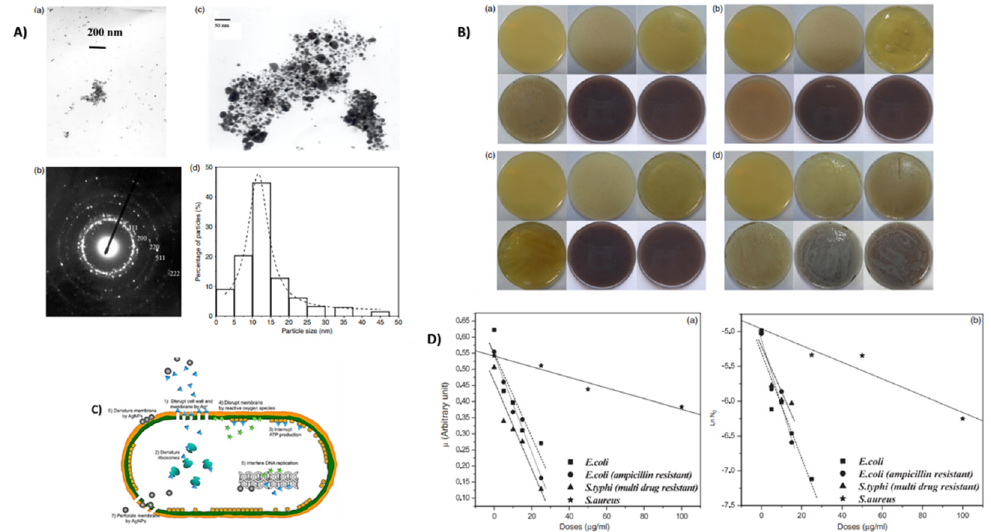
Figure 12. ( A ) shows silver nanoparticles with TEM microscope of different sizes; ( a ) accumulated and monodispersed form, ( b ) diffraction pattern, ( c ) higher magnification morphology of silver na- noparticles, ( d ) size range from 10–15 nm of AgNPs are depicted utilizing particle size distribution. ( B ) Preparation of various bacteria on agar plates of different concentrations of Ag NPs ( a ) E. coli ; ( b ) ampicillin-resistant E. coli ; ( c ) multi-drug resistant S. typhi ; ( d ) S. aureus . In each figure the con- centrations of silver nanoparticles are as follows: upper middle, 0 µg mL − 1 ; upper right, 5 µg mL − 1 ; bottom left, 10 µg mL − 1 ; bottom middle, 25 µg mL − 1 ; bottom right, 35 µg mL − 1 . Upper left plate, agar without nanoparticles and without bacterial inoculation. Scale bar equals 1 cm. ( C ) Mechanism ac- tion of Ag nanoparticle. ( D ) Effect of AgNPs at ( a ) bacterial growth rate constant and ( b ) initial cell count. Adapted from [182]. Reproduced with permission from